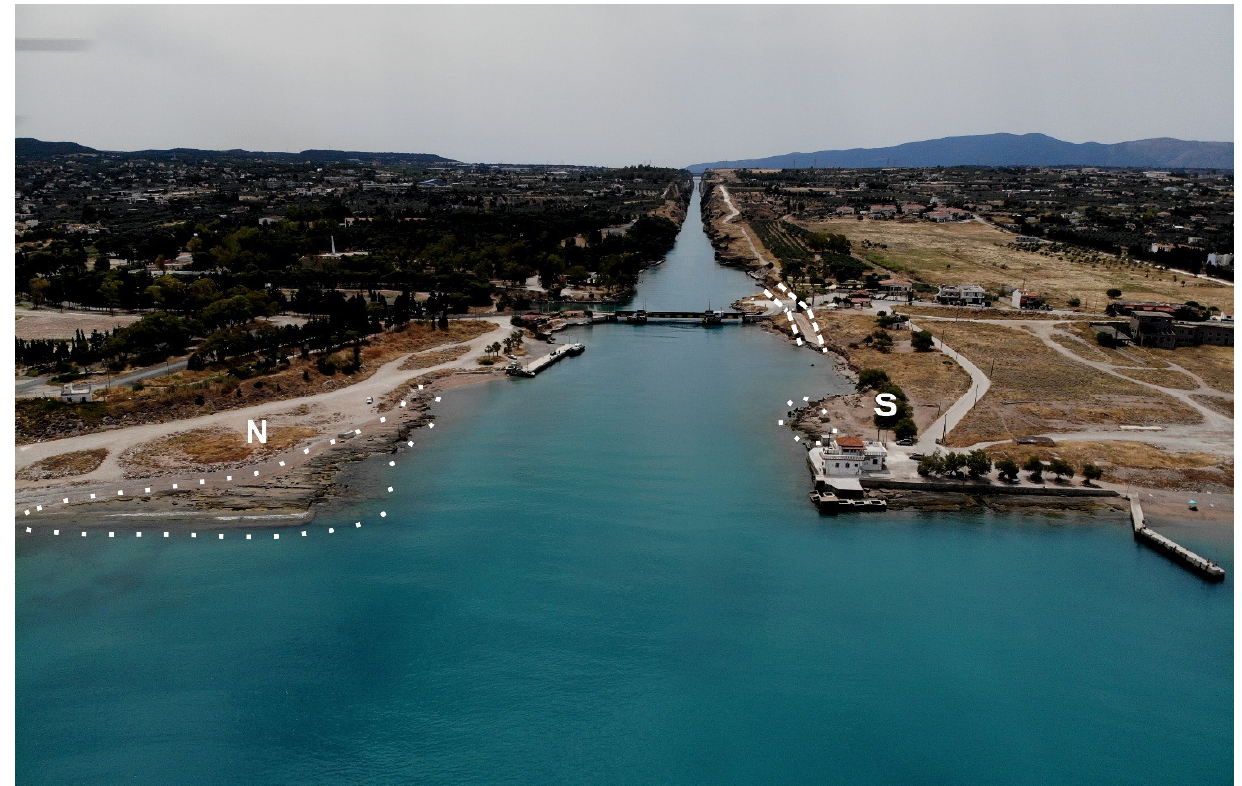
Figure 3. Diolkos area beachrock outcrops. The N corresponds to the northern part and S to the southern part. The Corinth isthmus (canal) can be seen in the middle. The white dashed lines indicate the exposed Diolkos ship slipway. The areas covered by white dotted lines indicate the studied beachrock.